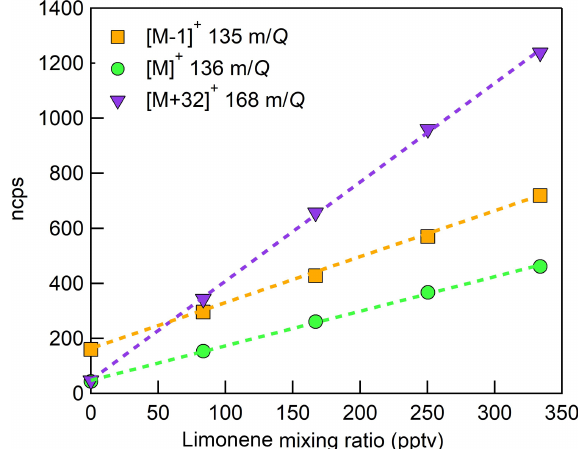
Figure 9. Normalized calibration of D -limonene for all major prod- uct ions (C 10 H + , 136 m/Q , green circles), (C 10 H + , 135 m/Q , or- 16 15 ange squares), and (C 10 H 16 O + , 168 m/Q , purple triangles). Cal- 2 ibration was performed in zero air at 14gkg − 1 specific humidity (80% RH at 23 ◦ C). Dashed lines are least squares best-fit lines (all · C 5 H 8 , 146 m/Q ) 6 R 2